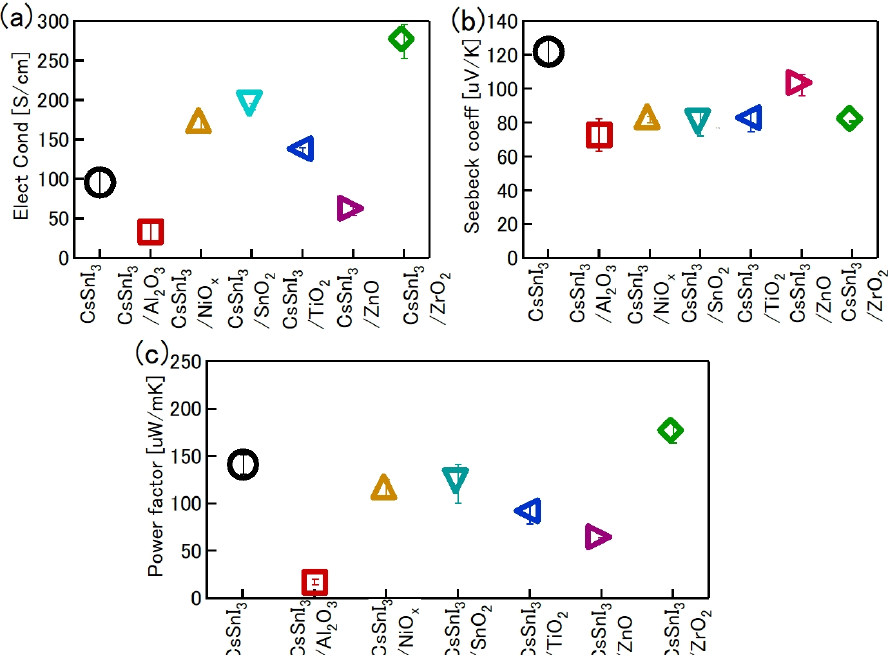
Figure 28. ( a ) Electrical conductivity variation with various CsSnI 3 /metal oxide nanocomposites, ( b ) Seebeck coefficient variation with various CsSnI 3 /metal oxide nanocomposites, ( c ) Power factor variation with various CsSnI 3 /metal oxide nanocomposite. Reproduced with permission [40]. Copyright 2022, American Chemical Society.